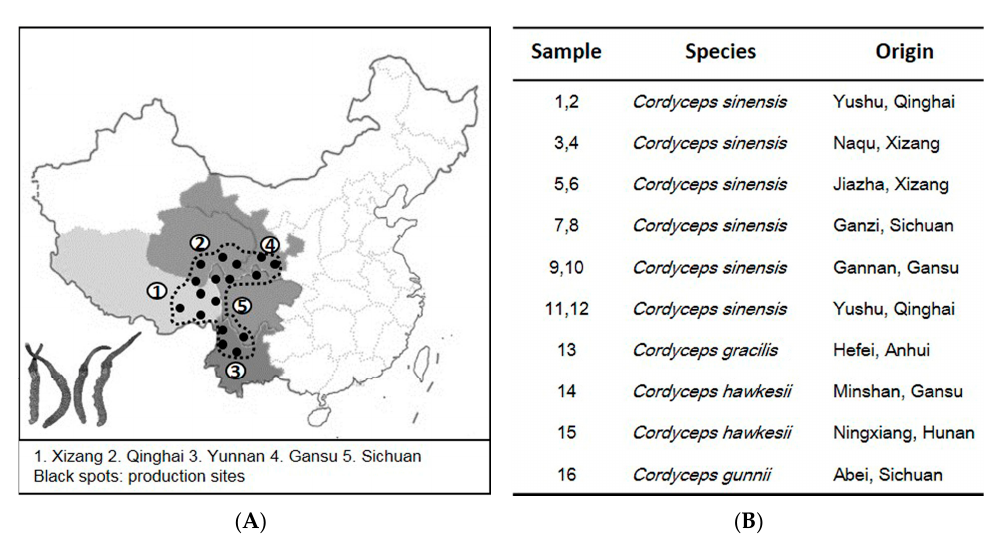
Figure 1. Cordyceps production in China and its collection. ( A ) The geographical locations of major Cordyceps production sites; ( B ) twelve commercial samples of C. sinensis (S1–S12) and its adulterants (S13–S16) collected in Hong Kong herbal markets were used in this experiment. Each sample had four batches, n = 4.